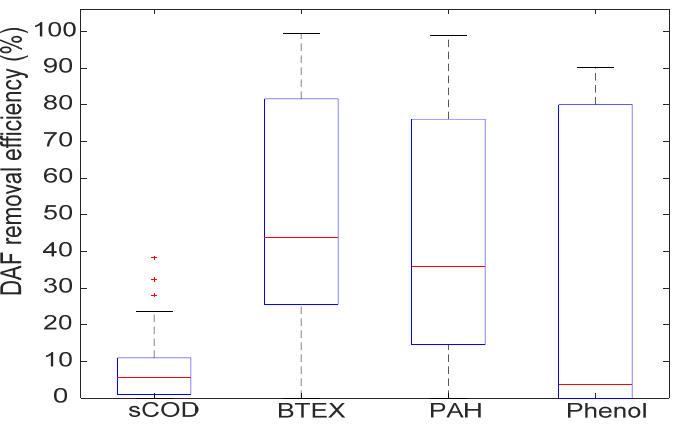
Figure 8. COD, BTEX, PAH and Phenol removal by DAF (8-month average).